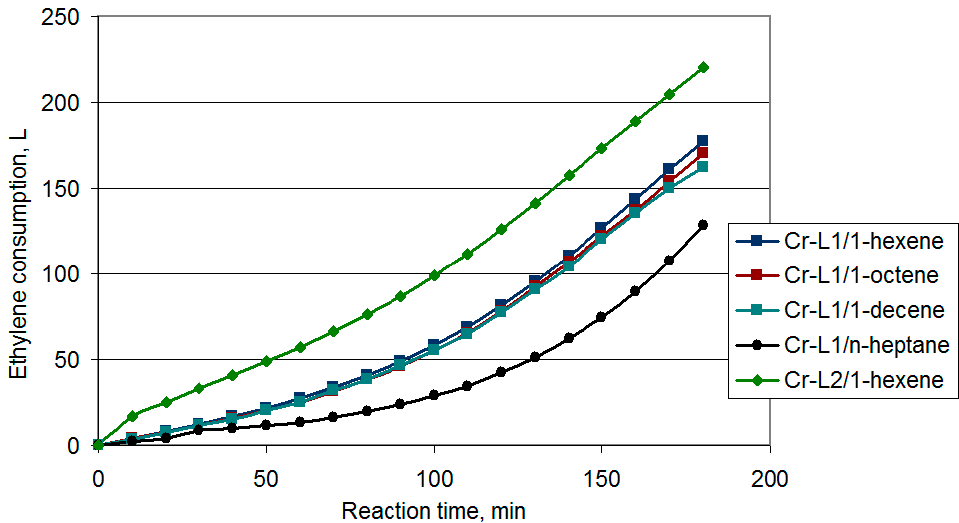
Figure 1. Ethylene consumption curves for ethylene oligomerization using Cr-PNP catalysts (Cr(acac) 3 (30 μ mol)/ PNP ligand (40 μ mol)) activated by MMAO-12 at [Al]/[Cr] ratio of 200, 120 mL of the solvent, 30 bar, 50 °C).